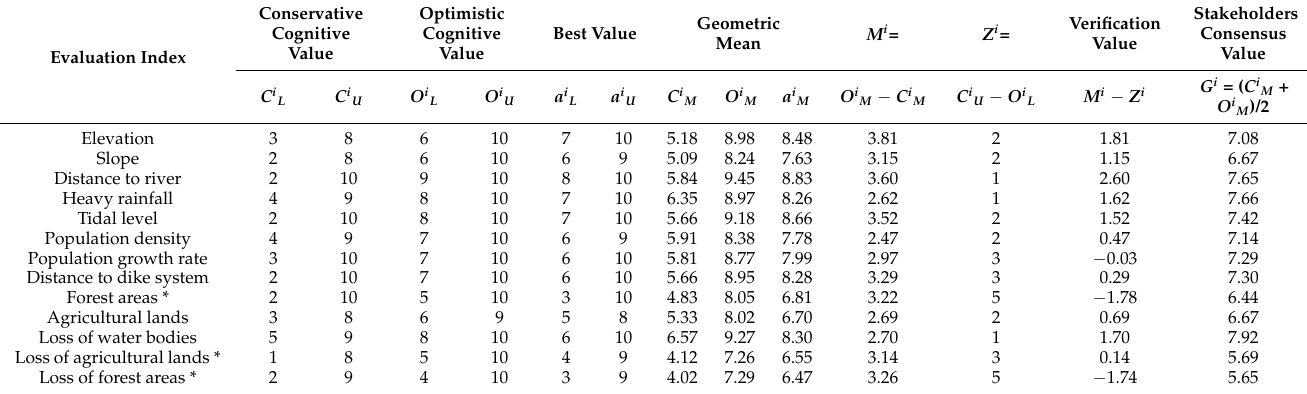
Table 2. The results of Fuzzy Delphi Method questionnaire—Criteria index.